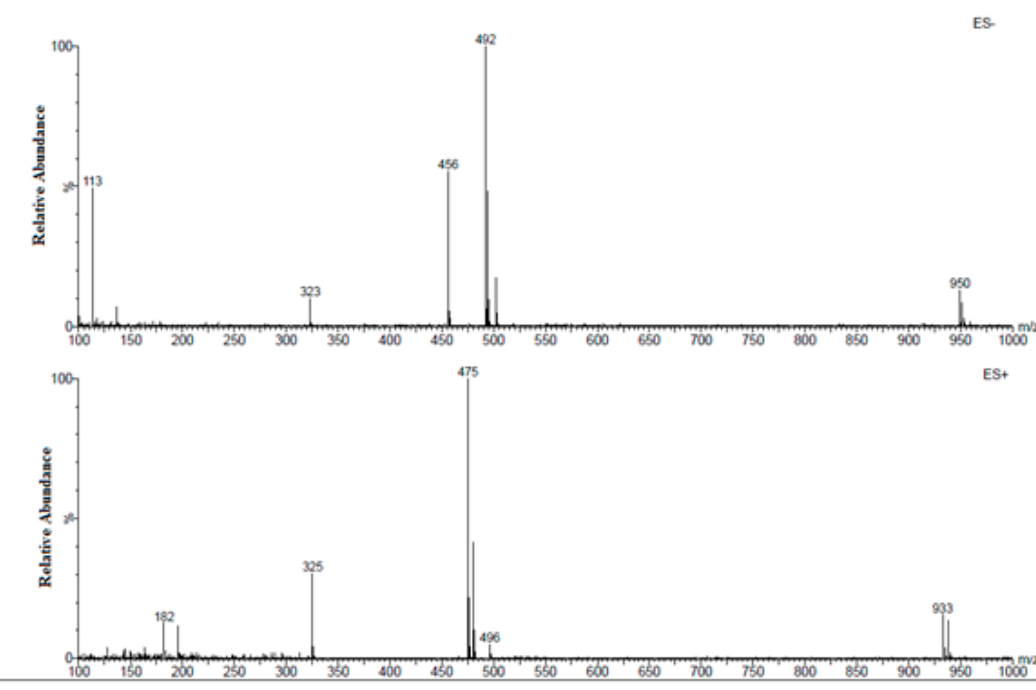
Figure 12. Full scan spectrum of amygdalin, HPLC retention time t R = 6.33 min, m / z 456 [M − H] − , m / z 950 [2M + Cl] − , m / z 492 [M + Cl] − , m / z 475 [M + Na] + , m / z 496 [M + K] + , and m / z 938 [2M + Na] + .